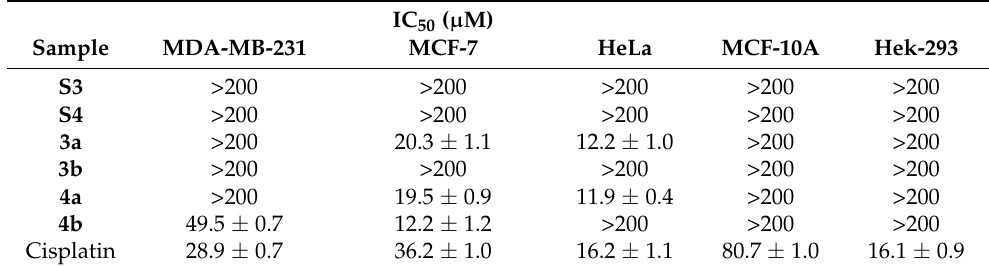
Table 3. IC 50 values of the studied metal complexes ( 3a,b and 4a,b ) and the ligands ( S3 and S4 ) expressed in µ